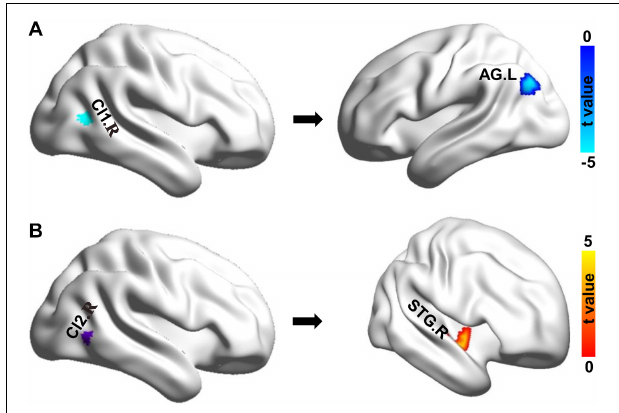
FIGURE 2 | Changes in resting-state functional connectivity. (A) Chess experts showed decreased functional connectivity between Cl1.R and left angular gyrus (AG.L). (B) Chess experts showed increased functional connectivity between Cl2.R and right superior temporal gyrus (STG.R) compared with novice